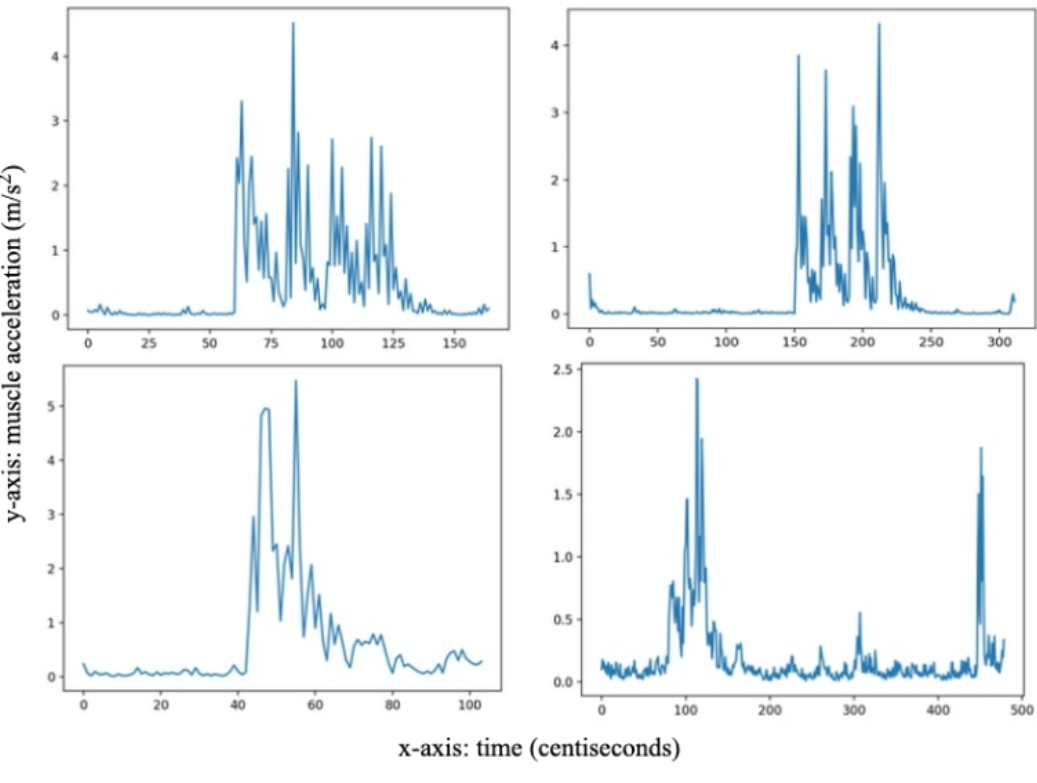
Figure 1. Normal and anomalous train-of-four (TOF) patterns; upper figures display normal TOF observations while bottom figures represent anomalies. Normality recordings are illustrated by the upper 2 patterns, where 4 clear peaks can be detected and that follow one another in a fixed time interval. The lower 2 patterns represent 2 simulated anomalies, where the 4 peaks cannot be clearly recognized from the TOF pattern; or where a wide gap in terms of time interval exists between peaks.